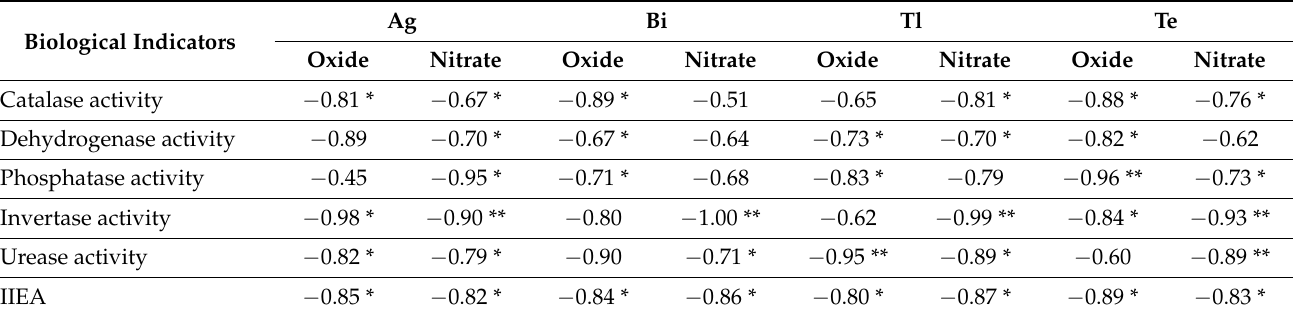
Table 2. Correlation coefficients (r) between the content of Ag, Bi, Tl, and Te in soil and enzymatic activity ( α =